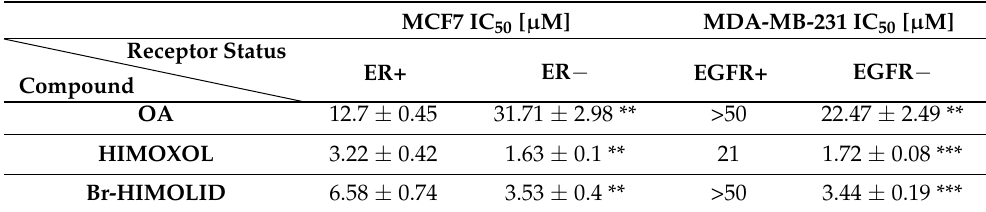
Table 1. Comparison of OA and cytotoxicity of its two semisynthetic derivatives in MCF7 ER+/ER − and MDA-MB-231 EGFR+/EGFR − cells. The IC 50 values were calculated based on the concentration– response curves assessed by MTT assay for 24 h. Statistical analysis shows significant differences when the biological effect of studied compounds in ER+/ER − and EGFR+/EGFR − cells was compared: ** p < 0.05, *** p <